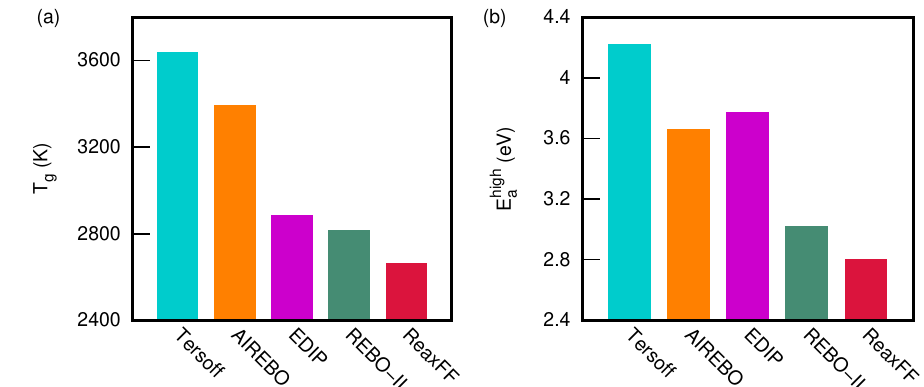
Figure 6. Average values of the ( a ) glass-transition temperature ( T g ) and ( b ) high-temperature activation energy ( E high a ) for all five